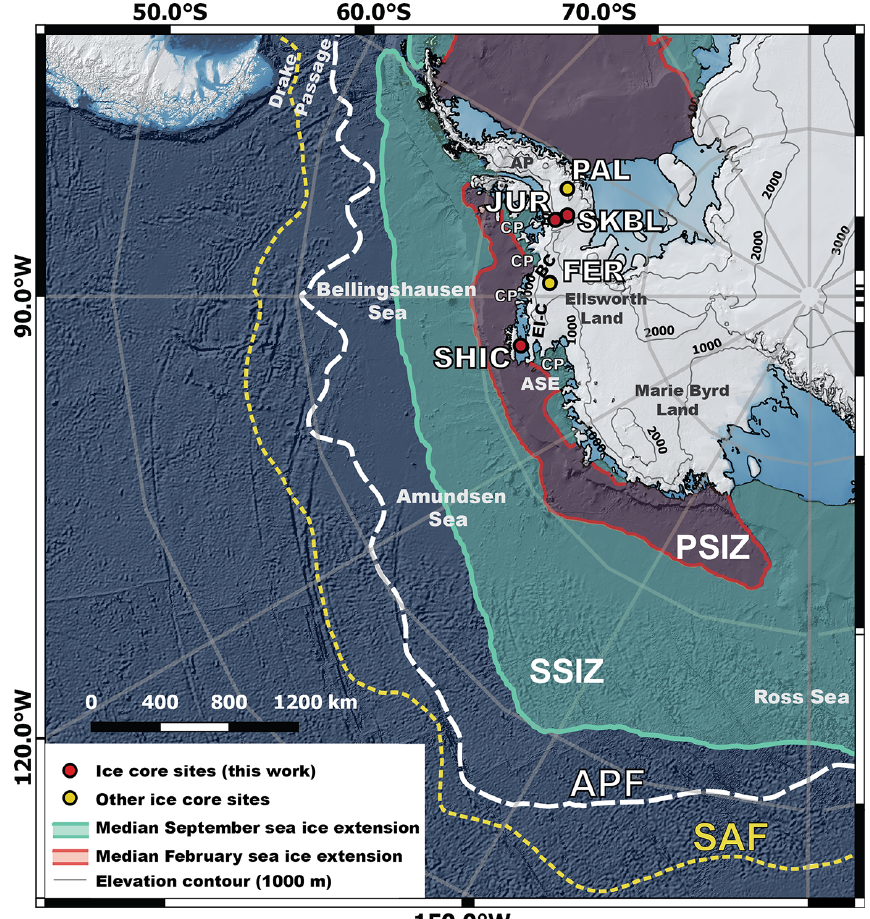
Figure 1. Map showing the location of the ice core sites and main oceanographic features considered in this study. The red circles show the locations of the three ice core sites. The pale green line shows the median September sea ice extension between 1980 and 2010CE, and the pale green area represents the seasonal sea ice zone (SSIZ). The red line shows the median February sea ice extension between 1980 and 2010CE, and the pale red area represents the perennial sea ice zone (PSIZ). SAF: Sub-Antarctic Front. APF: Antarctic Polar Front. CP: coastal polynya. EI-C: Eights Coast. BC: Bryan Coast. ASE: Amundsen Sea Embayment. PAL: Palmer ice core site. FER: Ferrigno ice core site. AP: Antarctic Peninsula.